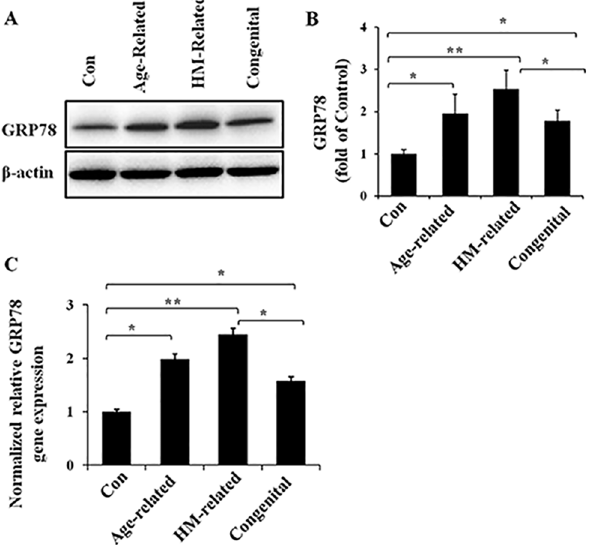
Fig 1. Up-regulated expression of the ER chaperone GRP78 at the mRNA and protein levels in the different cataract lens groups RNA and protein were extracted from human lens specimens. Western blotting was performed to detect the protein expression of GRP78 (Fig 1A and 1B), and β -actin was used as the internal control; real-time PCR was performed to detect the gene expression level of GRP78 in each group (Fig 1C), and 18S rRNA was used as the internal control gene (mean ± SD, n = 3). * P < 0.05; ** P < 0.001.